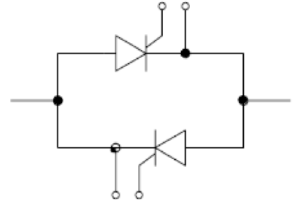
Figure 4. The AC “Back to Back” Switch configuration.